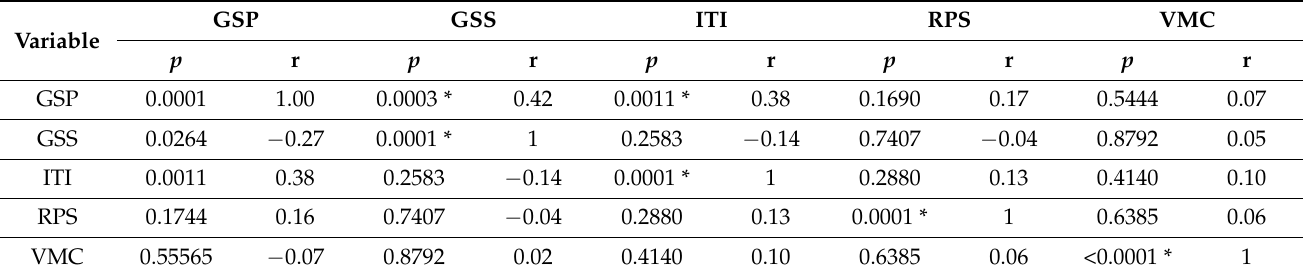
Table 8. Pearson correlation coefficients (r) of each variable GSP, GSS, ITI, RPS and